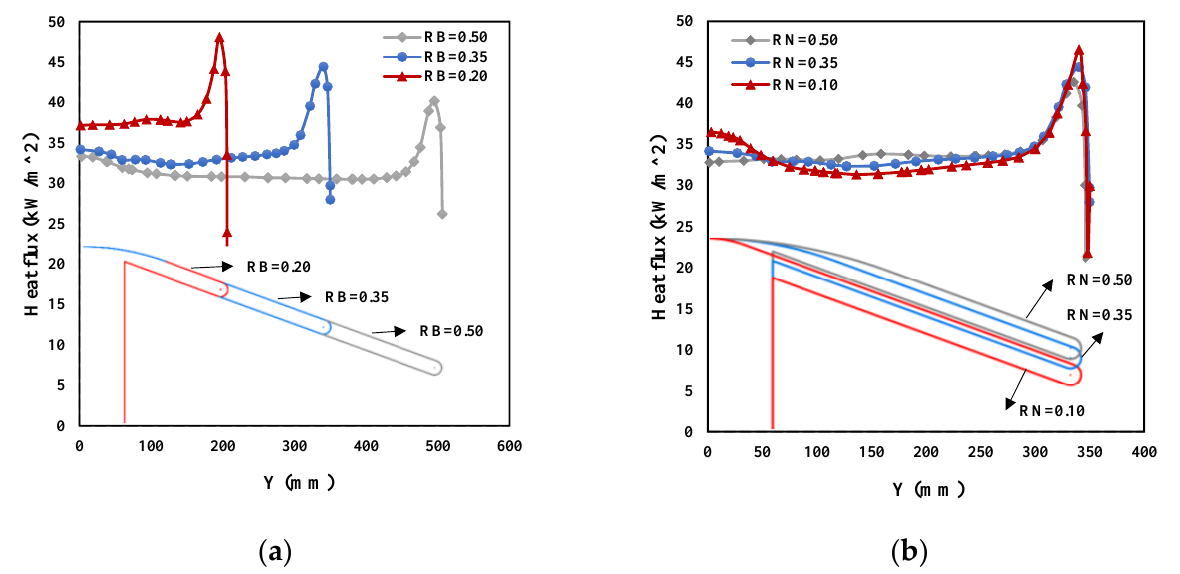
Figure 11. Heat flux distribution of case 0-0, case 1-1 to case 2-2: ( a ) R B is changed; ( b ) R N is changed.